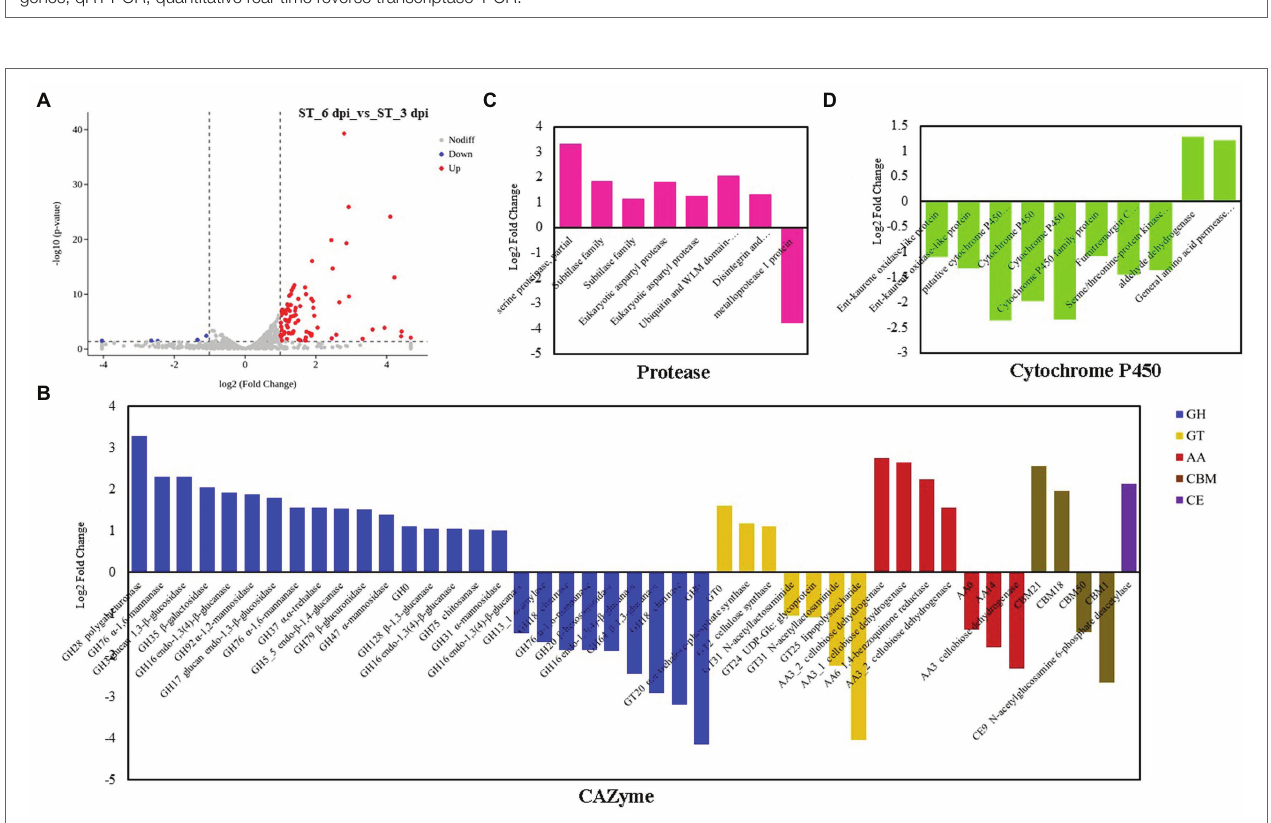
FIGURE 2 | Validation of the RNA-Seq data by qRT-PCR. (A) 11 DEGs from M. sextelata were selected for validation, and the y -axis shows the fold change expression at 3 and 6 days post-inoculation (dpi) compared with the non-inoculated samples. (B) Eight DEGs from P. penicillatus were selected, and the y -axis shows the fold change expression at 6 dpi compared with 3 dpi. Each data point was obtained from three biological replicates. DEGs, differentially expressed genes; qRT-PCR, quantitative real-time reverse transcriptase–PCR.